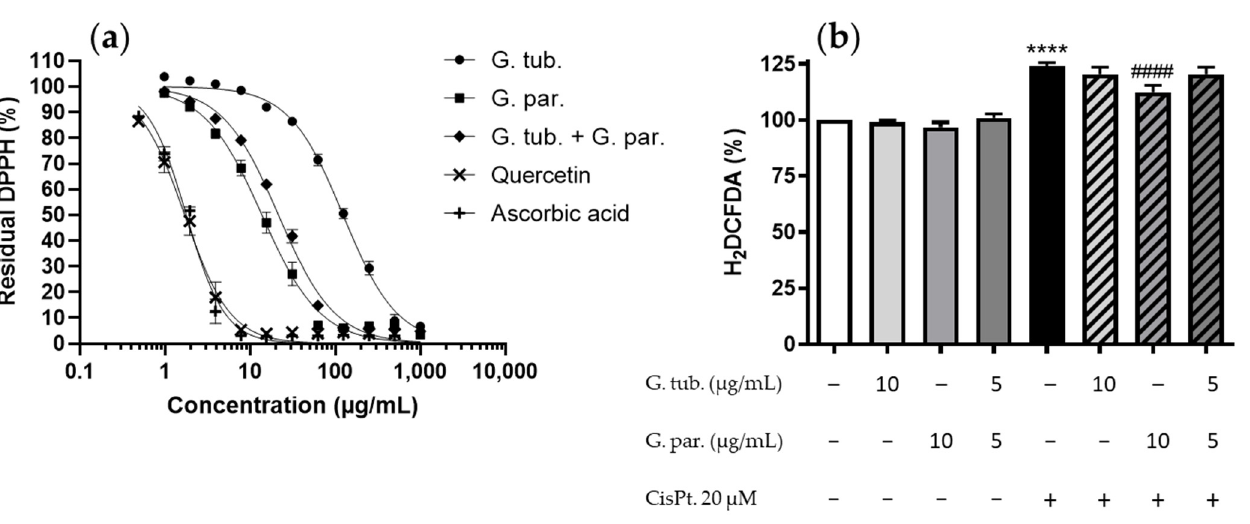
experiments (**** p < 0.0001 compared to controls; #### p < 0.0001, ### p < 0.001 ## p < 0.01, and # p < 0.05 compared to CisPt. 20 µ M). The signs + and − indicate the presence or the absence of the corresponding treatment, respectively.